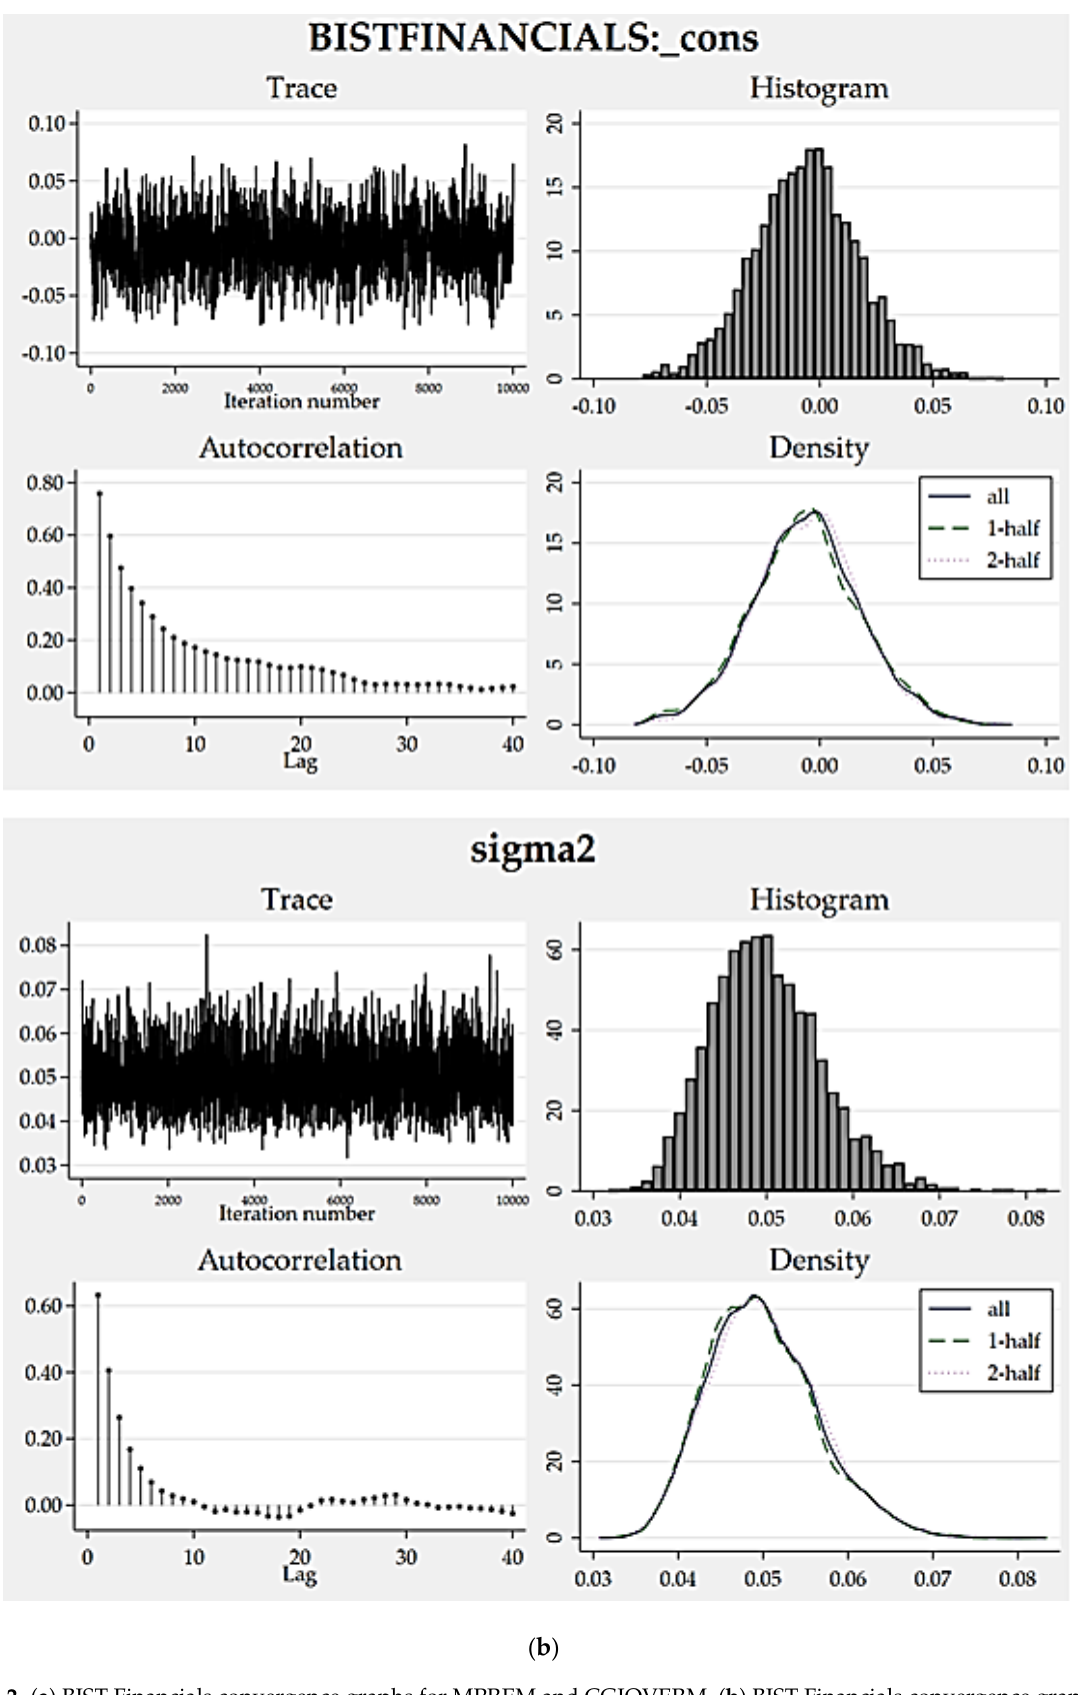
Figure 2. ( a ) BIST Financials convergence graphs for MPREM and CGIOVERM. ( b ) BIST Financials convergence graphs for model constant and variance. Source: STATA output (author’s compilation).